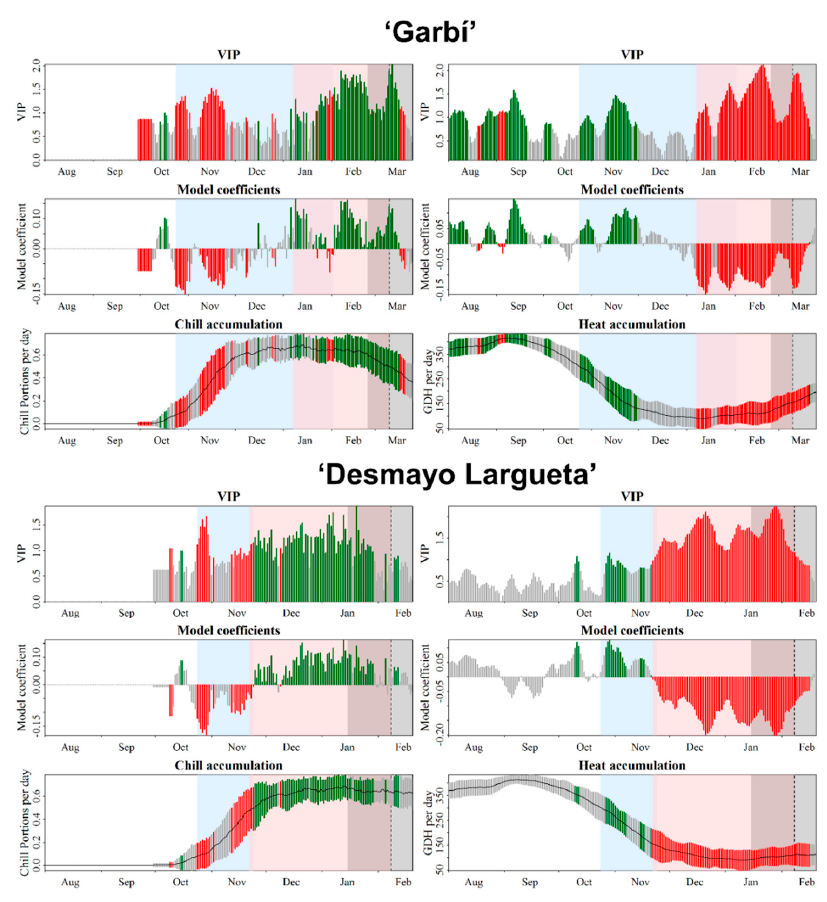
Figure 3. Results obtained from the partial least squares (PLS) regression analysis between blooming dates and daily mean chill and heat accumulation for ‘Garbí’ and ‘Desmayo Largueta’ in Mas de Bover using the dynamic model and the GDH model. Chilling phase delineation on the left, forcing phase on the right. Top: VIP values (variable importance of the projection). Middle: standardized coefficients of the PLS model. Bottom: daily mean chill/heat accumulation in chill portions and growing degree hour (GDH) units, left and right respectively: the length of the bars in this panel indicates the standard deviation of the daily chill/heat accumulation. For all panels, red and green bars indicate VIP ≥ 0.8; red bars, the standardized coefficients of the model are negative indicating that chill or heat accumulated on that day (left and right panel, respectively) result in an advancement of the flowering date; for green bars, coefficients are positive an indicate flowering date delay. Blue and pink background colors emphasize the delineated chilling and forcing phases, grey background represents the period when flowering occurs along the years studied, and the dotted line marks the median date of all the blooming dates recorded from 1979 to 2015. Two important findings were obtained while delineating the chill and forcing phases. The first one is the identification of an overlap period of the two studied phases in more than half of the cultivars: ‘Garbí’, ‘Desmayo Largueta’, ‘Cavaliera’, ‘Ramillete’, ‘Garrigues’, ‘Ardechoise’, ‘A-258 ′ , ‘Glorieta’, ‘Texas’, ‘Ferraduel’, ‘Tuono’, ‘Tarragonès’, ‘Tardy Nonpareil’, and ‘Primorskiy’ (Table 1, Figure 3 and Supplementary Figures S2 to S24). For those cultivars, the start of the forcing phase generally began when 50% or more of the chill had been accumulated, with the exception of ‘Tardy Nonpareil’ and ‘Primorskiy’ that started to accumulate heat when only about one third of the chill